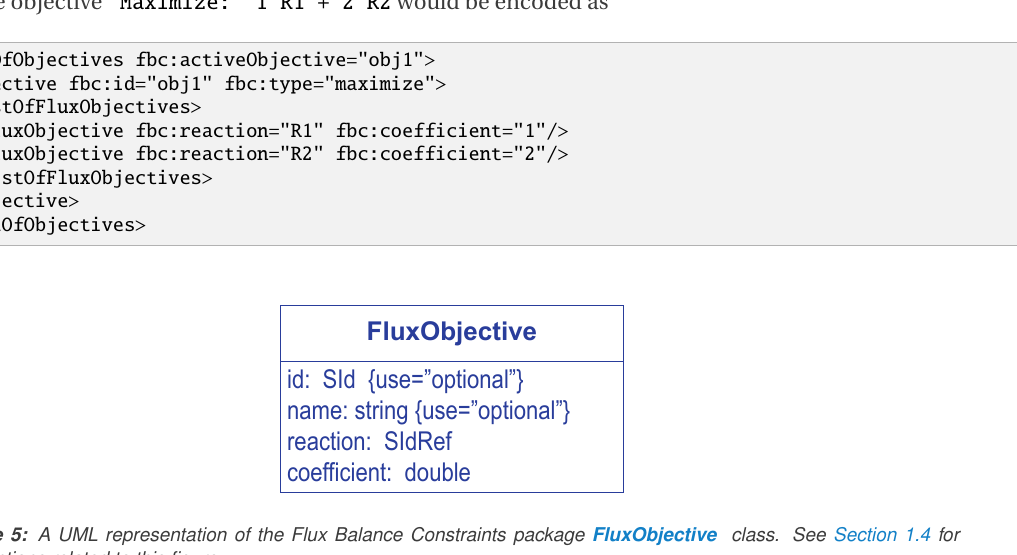
Figure 5: A UML representation of the Flux Balance Constraints package FluxObjective class. See Section 1.4 for conventions related to this figure.